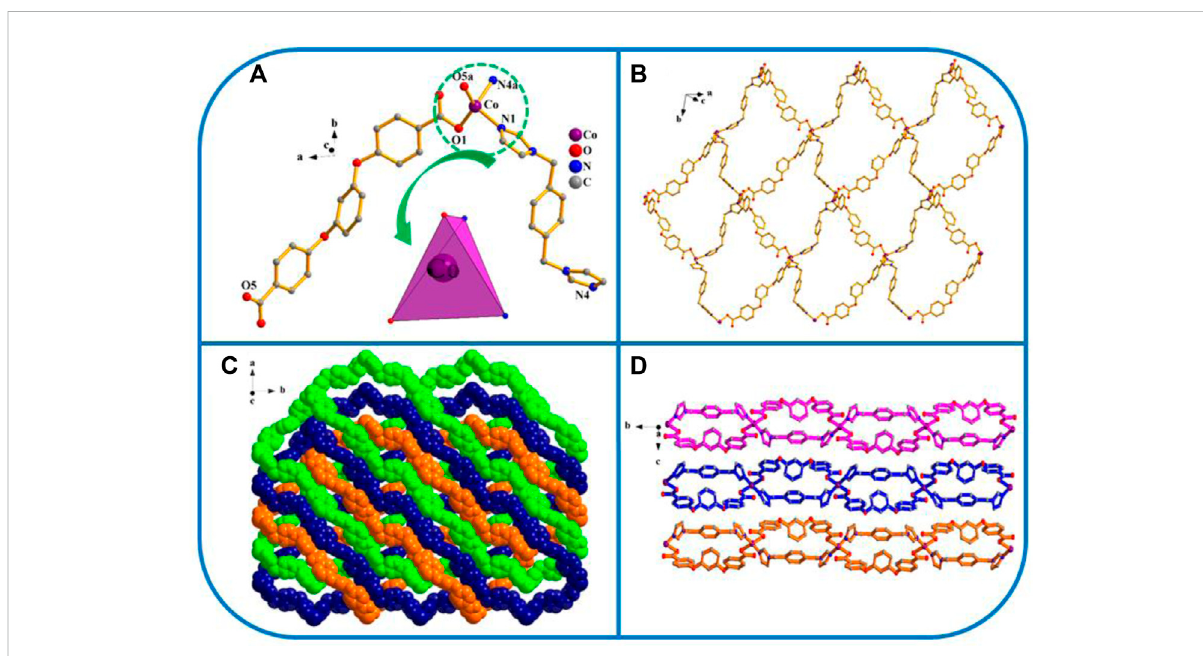
FIGURE 4 (A) Coordination unit of the Co ion in YMUN 4 ((hydrogen atoms are omitted for clarity), symmetry codes: (i) - x , y +1/2, - z +3/2; (ii) - x +3, y +1/2, - z +3/2;(iii)- x , y -1/2, - z +3/2;(iv) - x +3, y -1/2, - z +3/2.); (B) view ofthesingle2Dlamellarstructureof4; (C) view ofthethree-fold interpenetrating 2D strati fi ednetworkthroughtheidentical2Dlamellarstructuresoffouralongthe c axis; (D) viewofthe3Dframeworkthroughthe2Dstrati fi ednetwork with weak interactions occurring along the a axis.